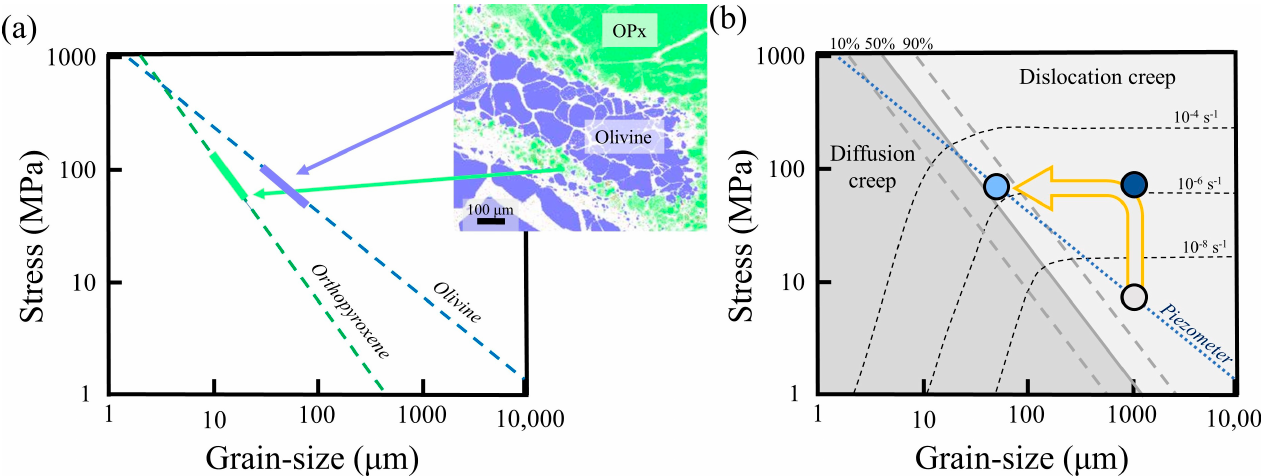
Figure 10. ( a ) Recrystallized grain size versus stress relations (piezometers) for olivine and opx from Van der Wal et al. [74] and Linckens et al. [75], respectively. The range of grain size for olivine (30–80 μ m) and opx (10–20) are shown as the thicker green and blue line segments on the piezometers, respectively. ( b ) Deformation mechanism map schematically showing the transition from the initial grain-size and stress (grey circle), the deformation mechanism of the porphyroclast microstructure after the stress conditions had changed (dark blue circle), and the deformation mechanism for the induced recrystallized grains of the mylonite (light blue circle). Flow law parameters from Hirth and Kohlstedt [21]. Olivine piezometer from Van der Wal et al. [74]. Lines of percentage represent the percent of dislocation creep compared to the total strain rate of dislocation creep plus diffusion creep.